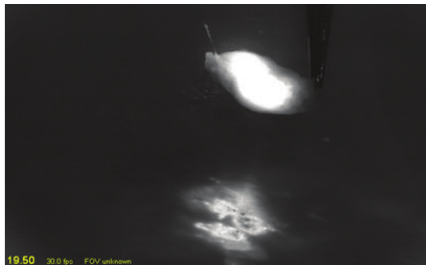
Figure 2: SPY imaging after excision of the sentinel node. The superior object is the SLN. The inferior area is the original chest wall melanoma